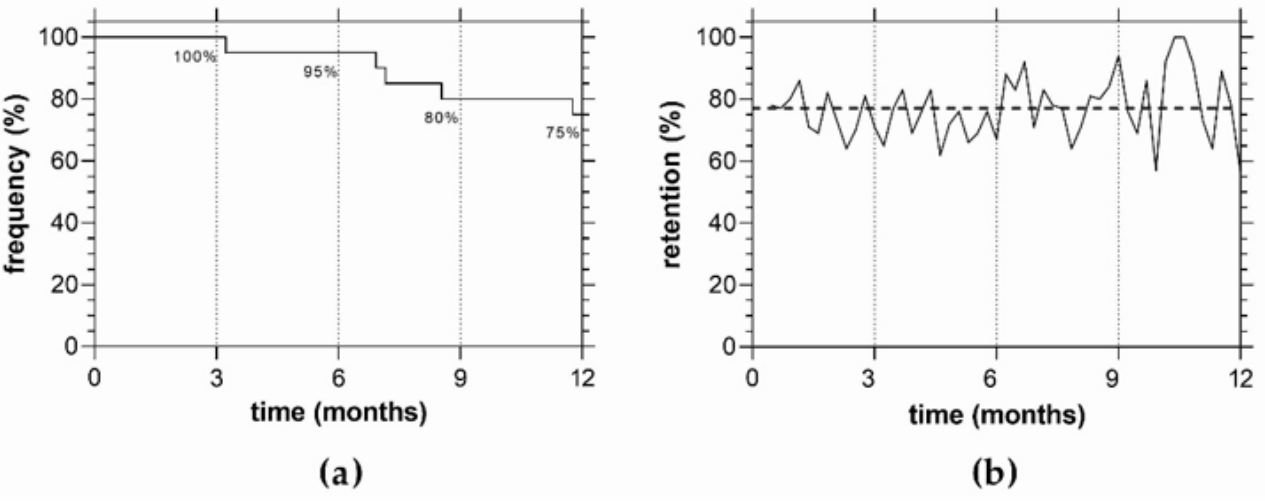
Figure 5. Time to dropout and compliance to weekly testing in n = 20 eyes that undertook visual field telemedicine with MRFh: ( a ) time to dropout over 12 months of visual field telemedicine with MRFh; ( b ) compliance to the request for weekly testing (7 + 1 days) returned by active participants over this period. Note the number of active participants decreased to 75% ( n = 15 of 20) as shown in ( a ).